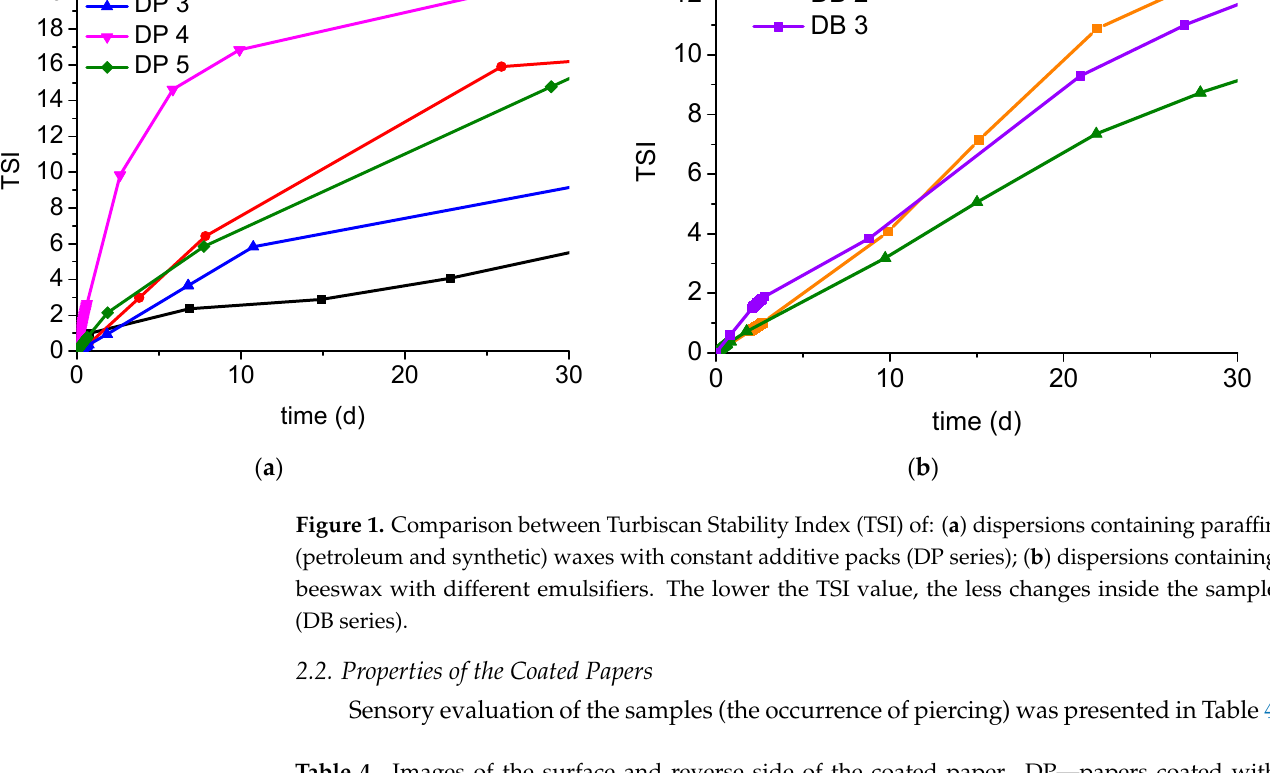
Table 4. Images of the surface and reverse side of the coated paper. DP—papers coated with paraffin-based dispersions, DB—papers coated with beeswax-based dispersions.